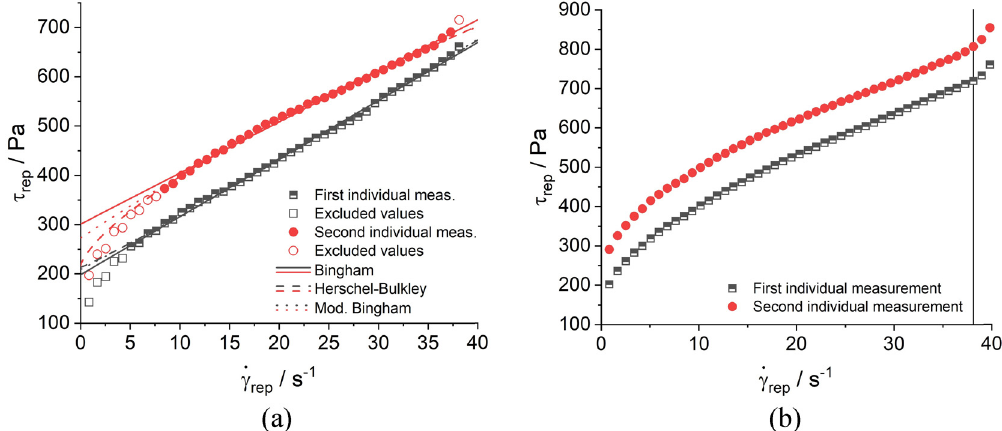
Figure 14: ( a ) Representative mean values of the fi rst and second individual measurements of the selected measurement series with excluded shear rates and fi tted models. ( b ) Representative measured values of an additional measurement with increased shear